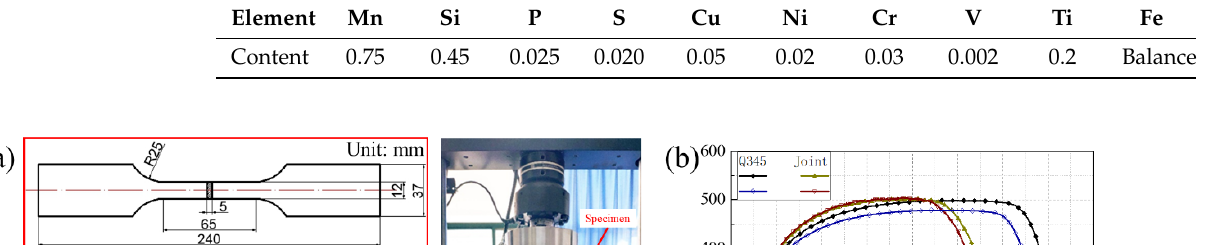
Table 1. Chemical composition of Q345 low alloy steel (%).